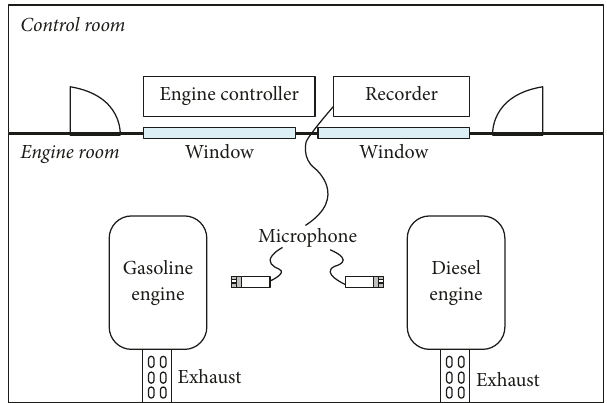
Figure 1: Overall schematic view of the laboratory